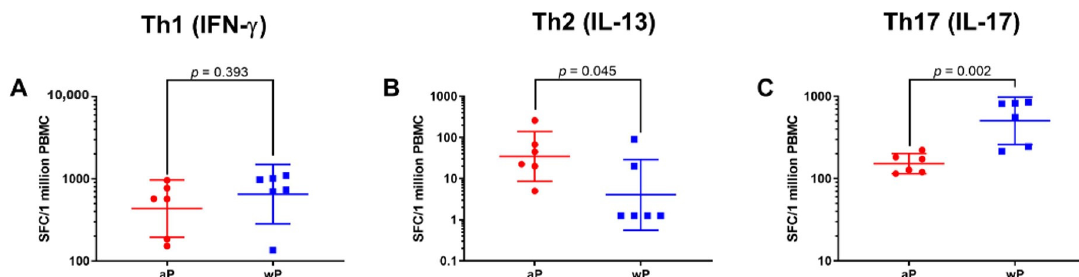
Figure 2. Assessment of the day 57 T cell response revealed di ff erences in the Th bias in animals primed with wP (blue square) or aP (red circle) vaccines. The data shown in the IFN- γ ( A ), IL-13 ( B ) and IL-17 ( C ) graphs are the individual values from day 57 with the geometric means and 95% CI noted with the corresponding lines. Statistical analysis was performed using an ANOVA model with the specific vaccine used to prime animals (aP or wP) as the fixed factor. There was a statistically significant di ff erence between wP vaccine and aP vaccine primed animals in the Th2 (IL-13) response ( p = 0.045) and Th17 (IL-17) response ( p = 0.002), but not for the Th1 (IFN- γ ) response ( p =